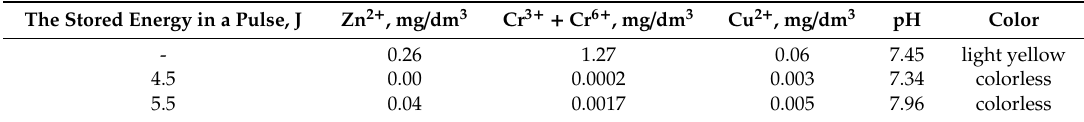
Table 9. Influence of energy in a pulse on the degree of purification of galvanic wastewater. The Stored Energy in a Pulse, J